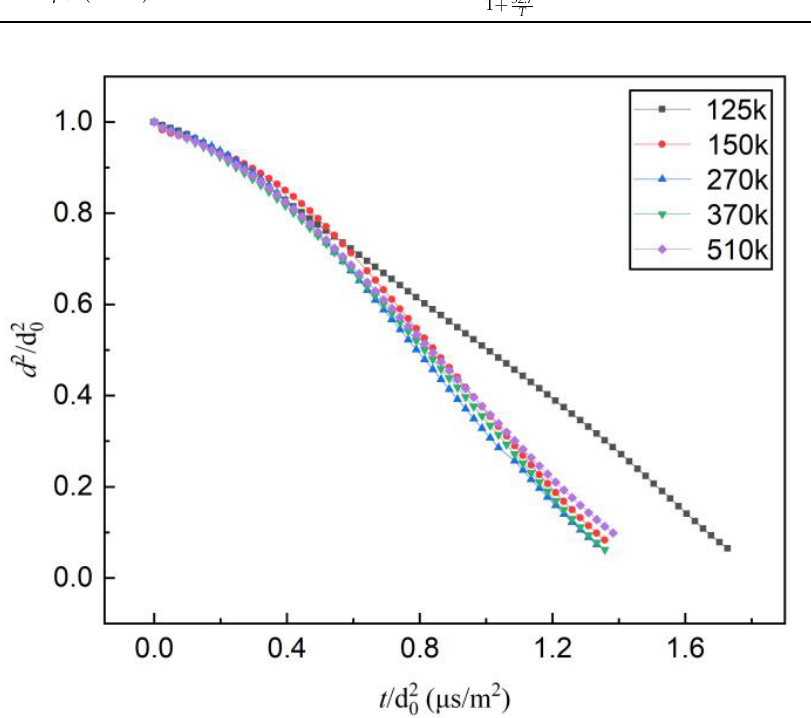
Figure 1. The calculated results at different numbers of